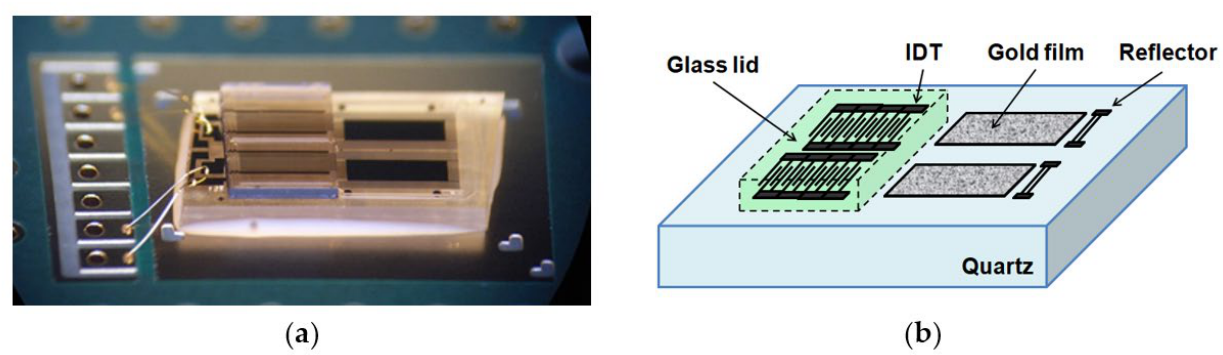
Figure 1. SH-SAW sensor chip. ( a ) Photograph of SH-SAW sensor chip; ( b ) schematic of SH-SAW sensor chip.